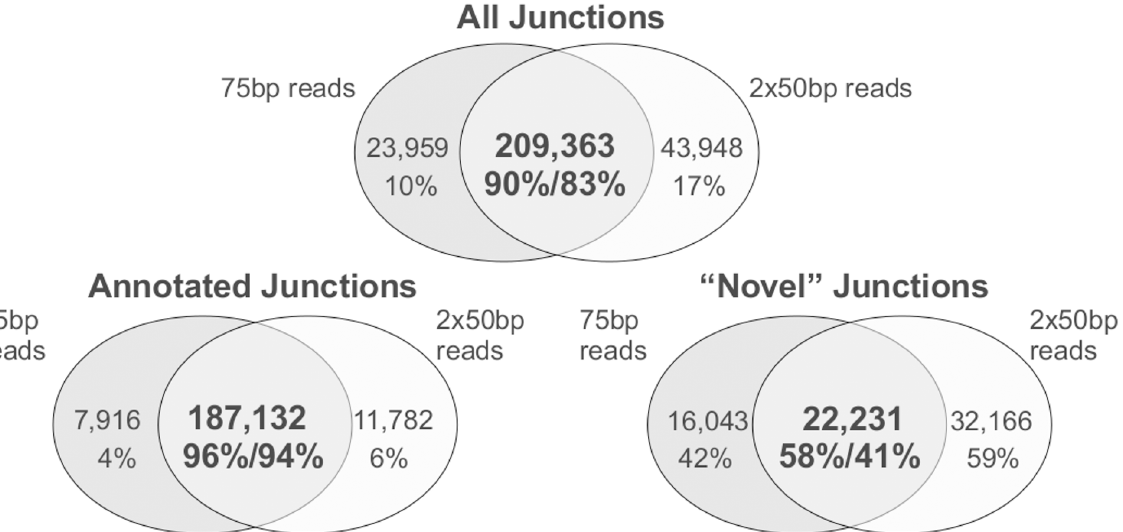
Fig 2. Concordance between the splice junctions identified by single end and paired-end RNA-seq reads. The three plots show all junctions (top), annotated junctions (bottom left), and novel junctions (bottom right).